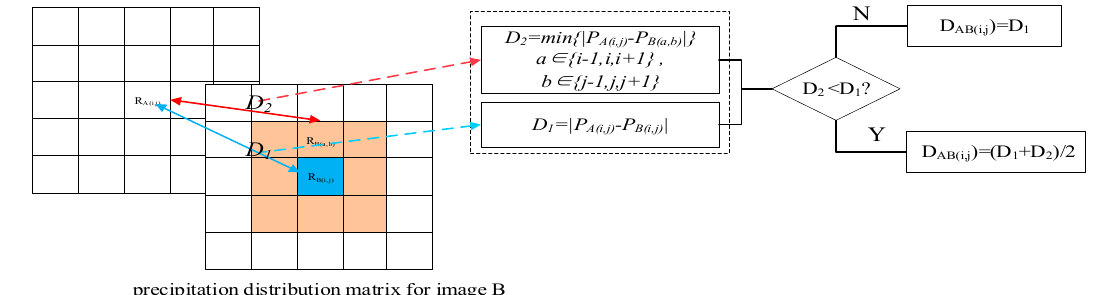
Figure 4. The distance between R A(i , j) and R B(i, j) of two precipitation distribution matrixes.